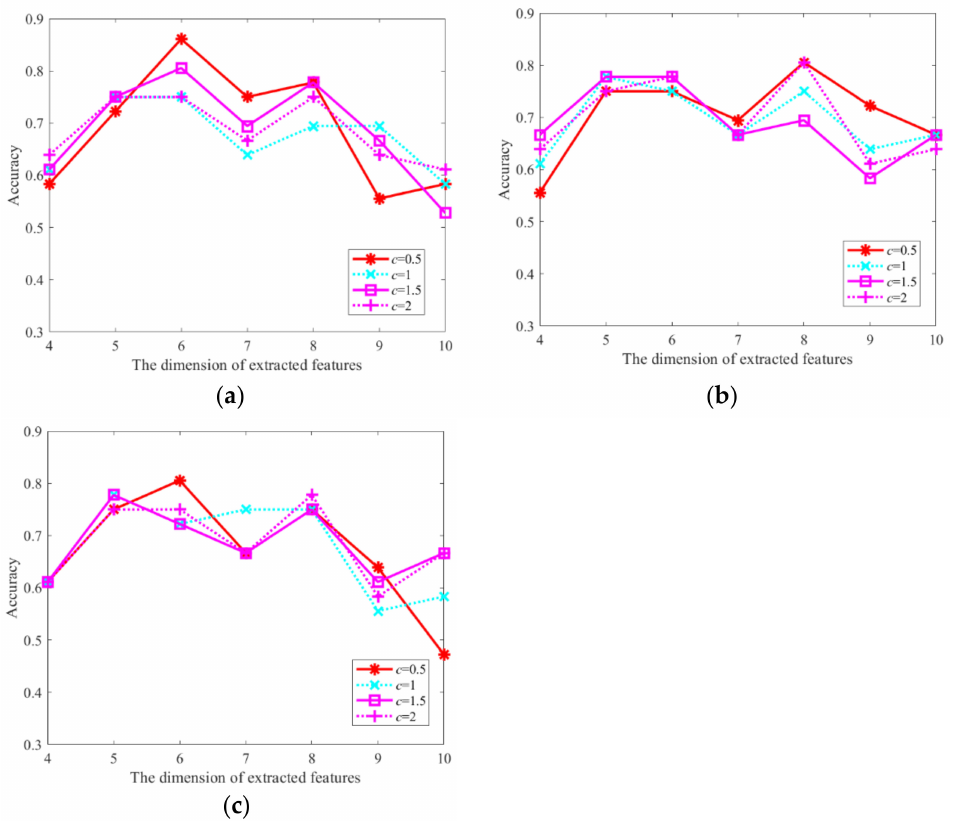
Figure 9. The accuracy of CCT-HTD under different c , different dimensions of extracted features, and different ε ( a ) The accuracy of CCT-HTD with different c for different dimensions of extracted features under ε = 0.1; ( b ) the accuracy of CCT-HTD with different c for different dimensions of extracted features under ε = 0.2; ( c ) the accuracy of CCT-HTD with different c for different dimensions of extracted features under ε =